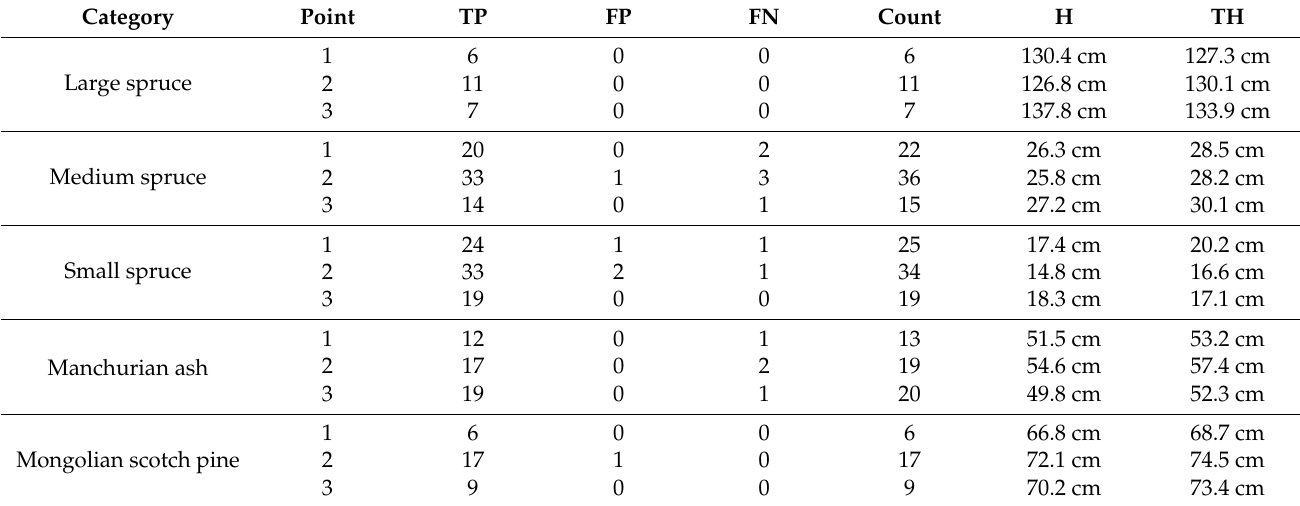
Table 5. Test results for three forms of spruce